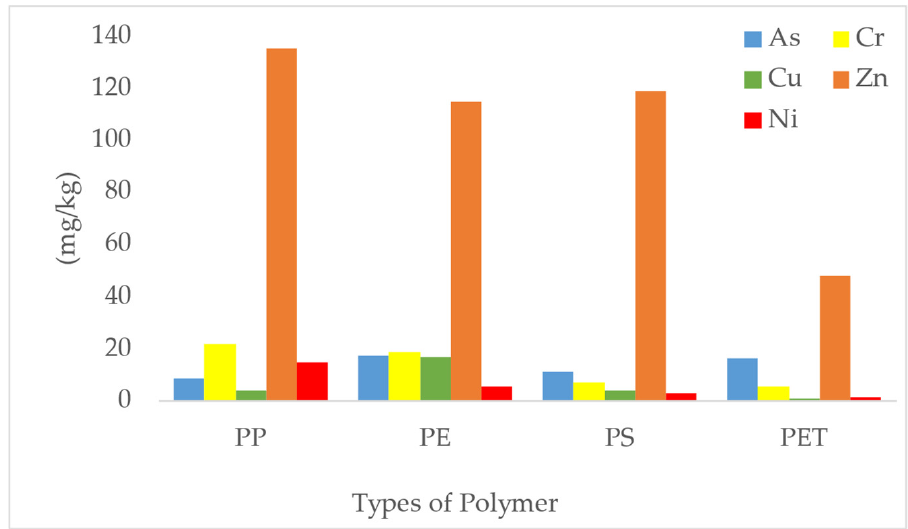
Figure 9. Concentrations of heavy metals in different types of polymers on ODEC beach .